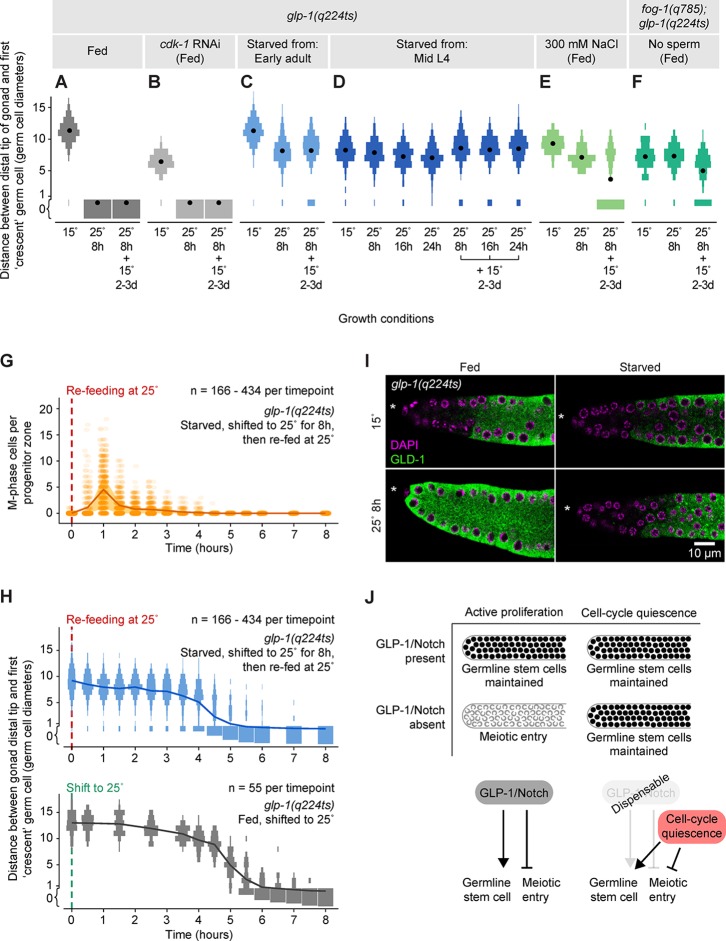
Quiescence induced by three different conditions maintains germline stem cells independent of GLP-1/Notch.(A–F) Distance between the gonad distal tip and the first ‘crescent’ germ cell for adult hermaphrodites of the genotypes and treatments shown. Animals were grown at 15°C, shifted to 25°C for 8, 16, or 24 hr, and then returned to 15°C for 2–3 days. Gonads were collected prior to the temperature shift (15°C), immediately following the temperature shift (25°C for 8 hr, 25°C for 16 hr, or 25°C for 24 hr), and following the 15°C recovery period (… + 15°C for 2–3 days). Data are plotted as vertical histograms, with black circles denoting means. n = 55–488 gonadal arms per time point. (G) Time course showing the number of M-phase cells per progenitor zone in glp-1(q224ts) hermaphrodites starved from early adult, shifted to 25°C for 8 hr, and then re-fed at 25°C. Lines connect means, and shaded areas show interquartile ranges. (H) Time courses showing distance between the gonad distal tip and the first ‘crescent’ germ cell. Top, hermaphrodites starved from early adult, shifted to 25°C for 8 hr, and then re-fed at 25°C. Bottom, hermaphrodites fed continuously and shifted to 25°C at the early adult stage. Data are plotted as vertical histograms, with lines connecting means. Sample sizes in G, H indicate number of gonadal arms. (I) Images of distal gonads dissected from adult hermaphrodites and stained with DAPI to visualize DNA (magenta) and anti-GLD-1 (green). Gonads were dissected before and after 8 hr at 25°C. Left-hand panels, fed adult hermaphrodites. Right-hand panels, hermaphrodites starved from early adult. Asterisks, distal gonad ends. (J) Schematic summarizing the effect of cell-cycle quiescence on germline stem cell maintenance. Under conditions of active proliferation, GLP-1/Notch is required for germline stem cell maintenance. Under quiescent conditions, GLP-1/Notch is dispensable. Source data for A–F are available in Figure 6—source data 1. Source data for G, H are available in Figure 6—source data 2.DOI:
http://dx.doi.org/10.7554/eLife.10832.01810.7554/eLife.10832.019Figure 6—source data 1.Temperature-shift experiments of glp-1(q224) hermaphrodites.This comma-separated value file contains measurements of the distance between the gonad distal tip and the first ‘crescent’ germ cell in temperature-shifted glp-1(q224) hermaphrodites (Figure 6A–F). Distances are measured in germ cell diameters. Each row of the file represents a single gonadal arm. Descriptors include growth conditions (fed, cdk-1 RNAi, starved from early adult, starved from mid-L4, 300 mM NaCl, no sperm) and temperature (15°C; 25°C for 8 hr; 25°C for 16 hr; 25°C for 24 hr; 25°C for 8 hr + 15°C for 2–3 days; 25°C for 16 hr + 15°C for 2–3 days; 25°C for 24 hr + 15°C for 2–3 days).DOI:
http://dx.doi.org/10.7554/eLife.10832.01910.7554/eLife.10832.020Figure 6—source data 2.Time courses of temperature-shifted glp-1(q224) hermaphrodites.This comma-separated value file contains counts of M-phase cells and distances between the gonad distal tip and the first ‘crescent’ germ cell for two groups of animals: (i) glp-1(q224ts) hermaphrodites starved from early adult, shifted to 25°C for 8 hr, and then re-fed at 25°C, and (ii) glp-1(q224ts) hermaphrodites fed continuously and shifted to 25°C at the early adult stage (Figure 6G–H). Distances are measured in germ cell diameters. Each row of the file represents a single gonadal arm. Descriptors include treatment group (fed, starved) and time. NA, not determined.